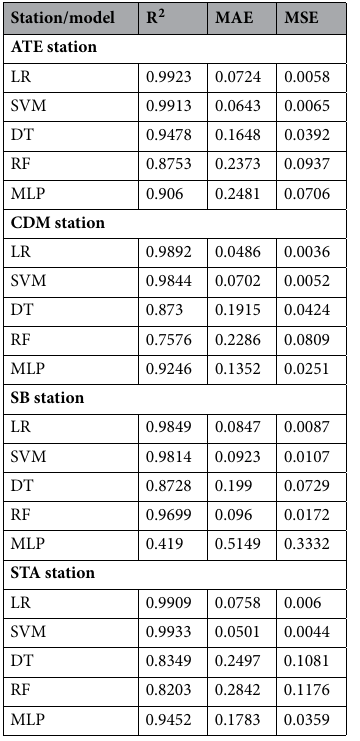
2 Table 3. Result of the R , MAE and MSE metrics applied to the forecast results for the analyzed models. The results are separated by station (ATE, CDM, SB and STA).